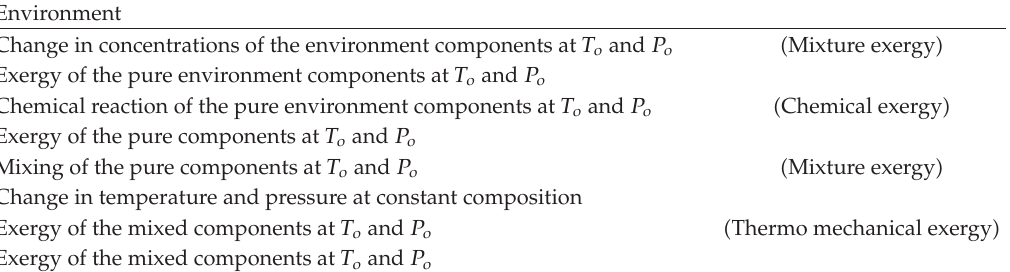
Table 3: Subdivision of the